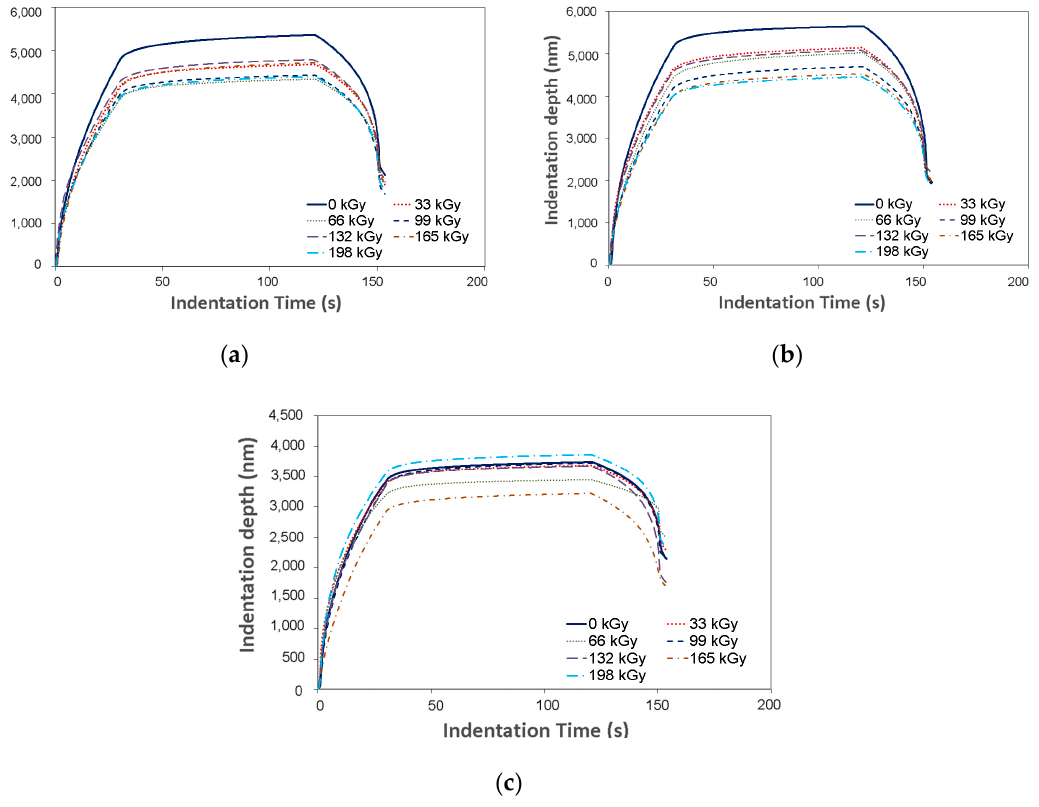
Figure 9. Indentation creep (indentation depth vs. indentation time): ( a ) PA 6; ( b ) PA 66; ( c ) PA 9T.